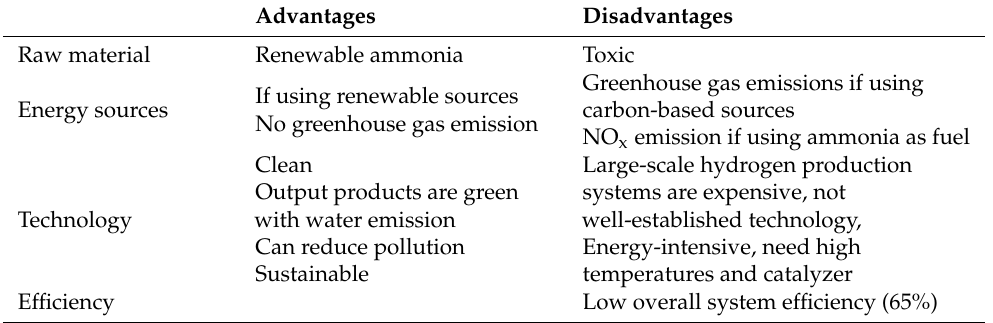
Table 13. Advantages and disadvantages of using ammonia for hydrogen production. Advantages